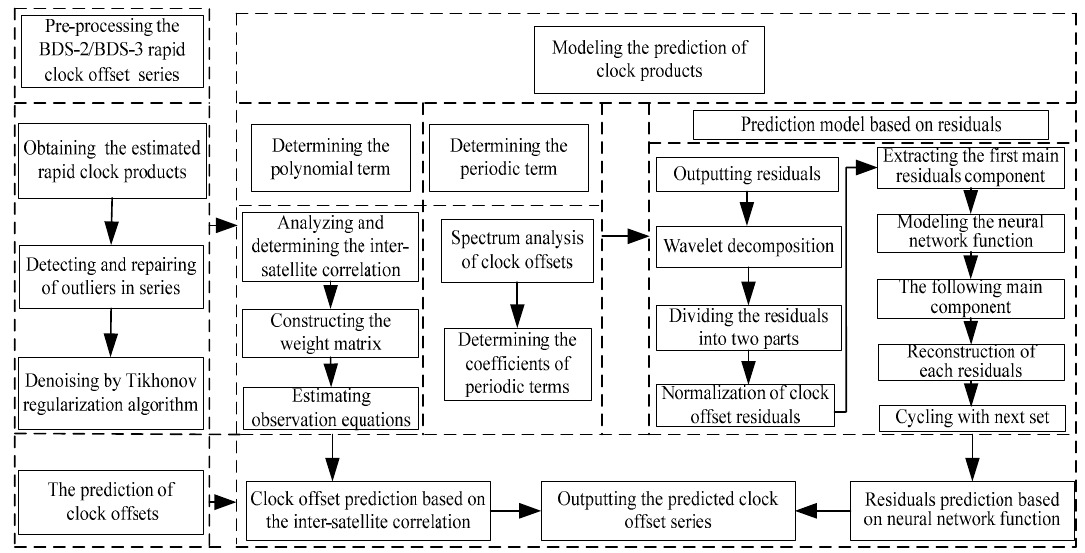
Figure 2. Flowchart for the procure of clock offset prediction.